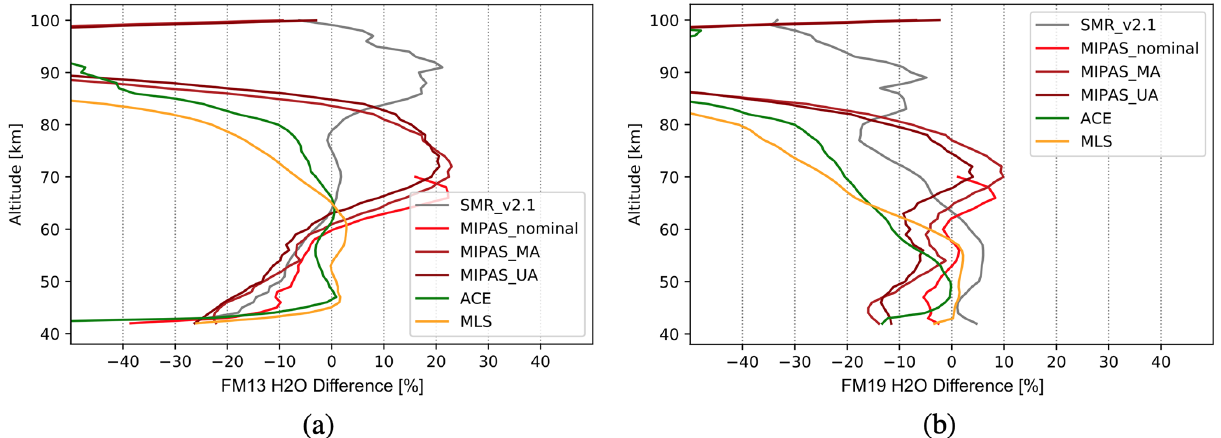
Figure 12. Summary of relative differences of SMR v3.0 H 2 O concentrations with respect to those from SMR v2.1, as well as those retrieved from measurements by all other instruments considered in this study. For the sake of clarity, errors are not shown. (a) FM13 comparison. (b) FM19